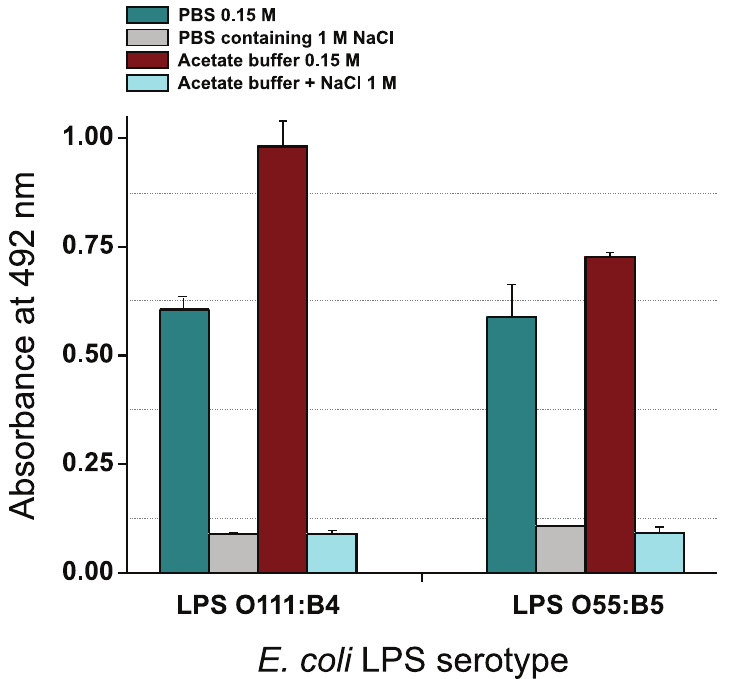
Fig 4. Influence of pH and ionic strength on LPS binding to casein hydrolysate (hCAS)-coated plates. FITC-LPSs from E . coli serotypes O111:B4 and O55:B5, diluted at 5 μ g/ml in PBS-EDTA (pH 7.2) and acetate buffer-EDTA (pH 5.6) prepared 0.15 M, or the same buffers containing 1M NaCl, were added to hCAS-coated plates.